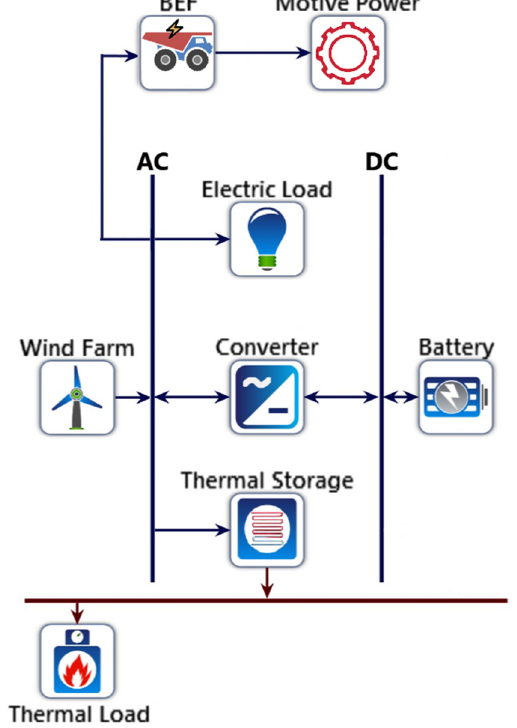
Figure 7. All-renewable system with battery electric fleet (BEF) and battery storage configuration.